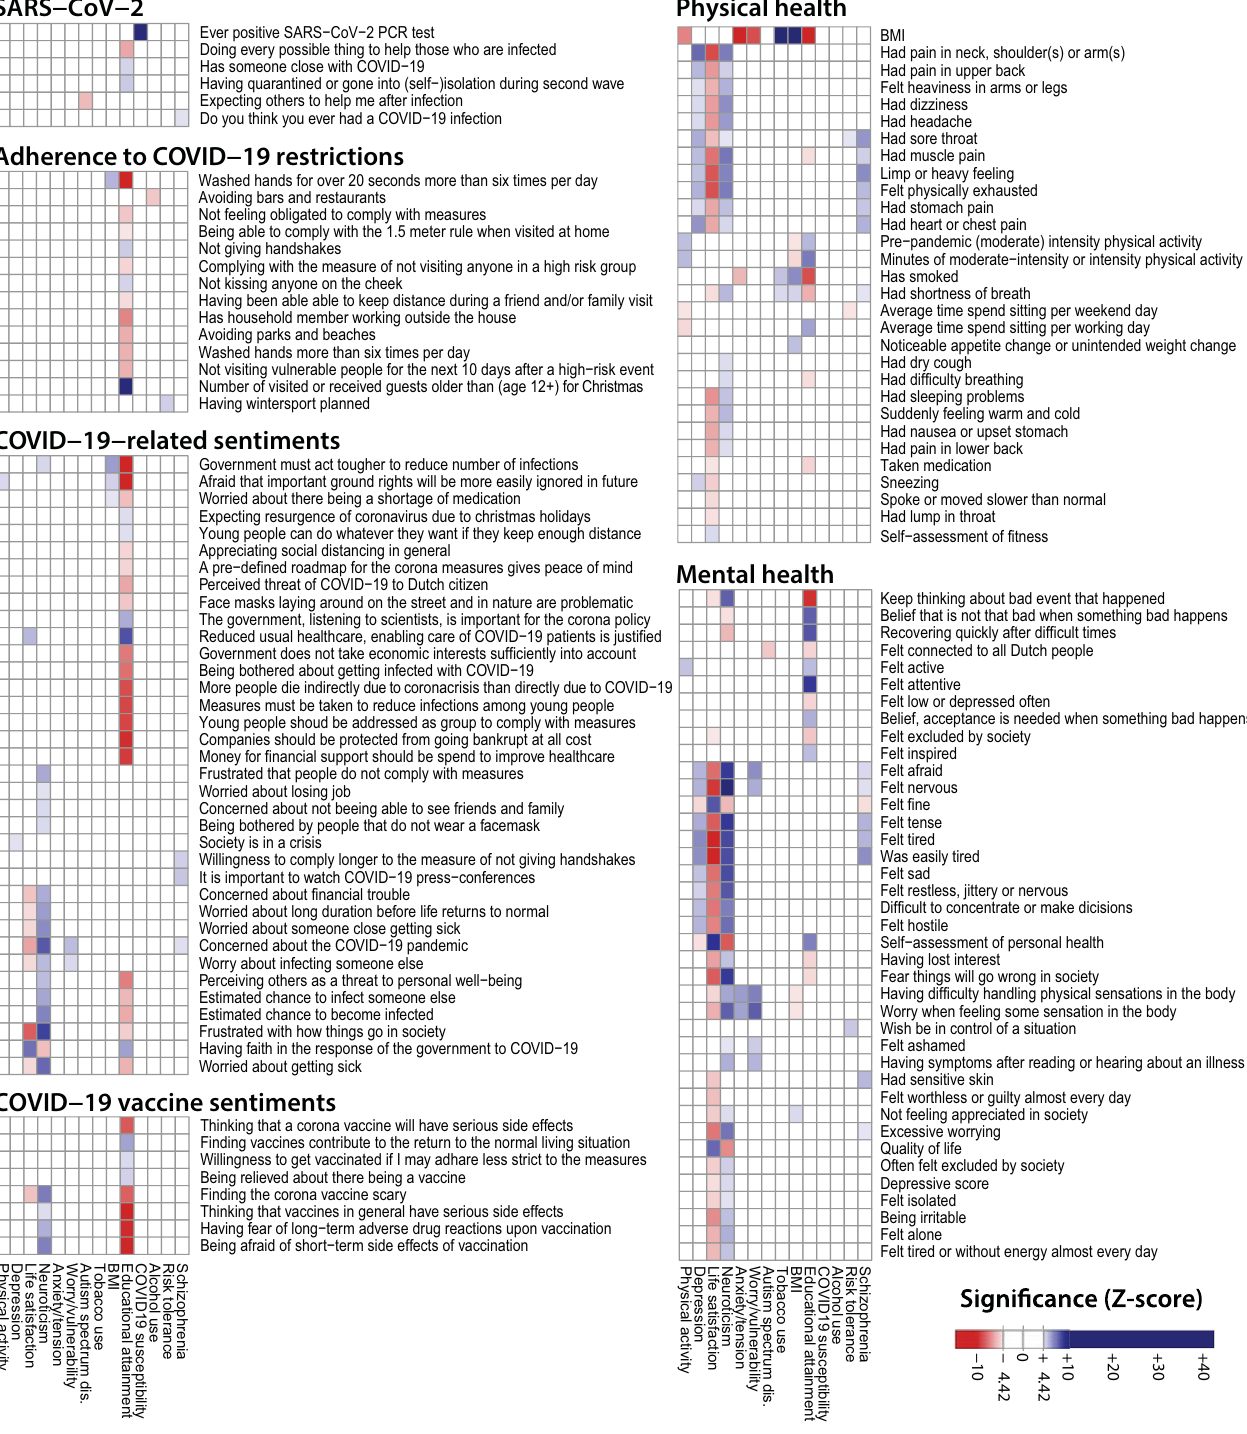
Fig 2. Significant associations of PGSs and question answers at baseline. A Z-score heatmap highlighting significant associations between questionnaire outcome items and polygenic scores (PGSs). In total, we analysed 288 questionnaire items and questionnaire-derived items, of which 143 have a significant association with at least one PGS. We observe significant associations of the PGSs for Depression, Life satisfaction, Neuroticism and Schizophrenia with wellbeing. Additionally, COVID-19 sentiments are associated to PGS traits including Educational attainment, Neuroticism and Worry/Vulnerability. Associations were estimated between PGS and outcome items using a multivariate model (linear, logistic, or ordered logistic regression) with age, sex, household size, having children and having chronic disease used as covariates. The ‘Ever positive SARS-CoV-2’ item was determined from answers to